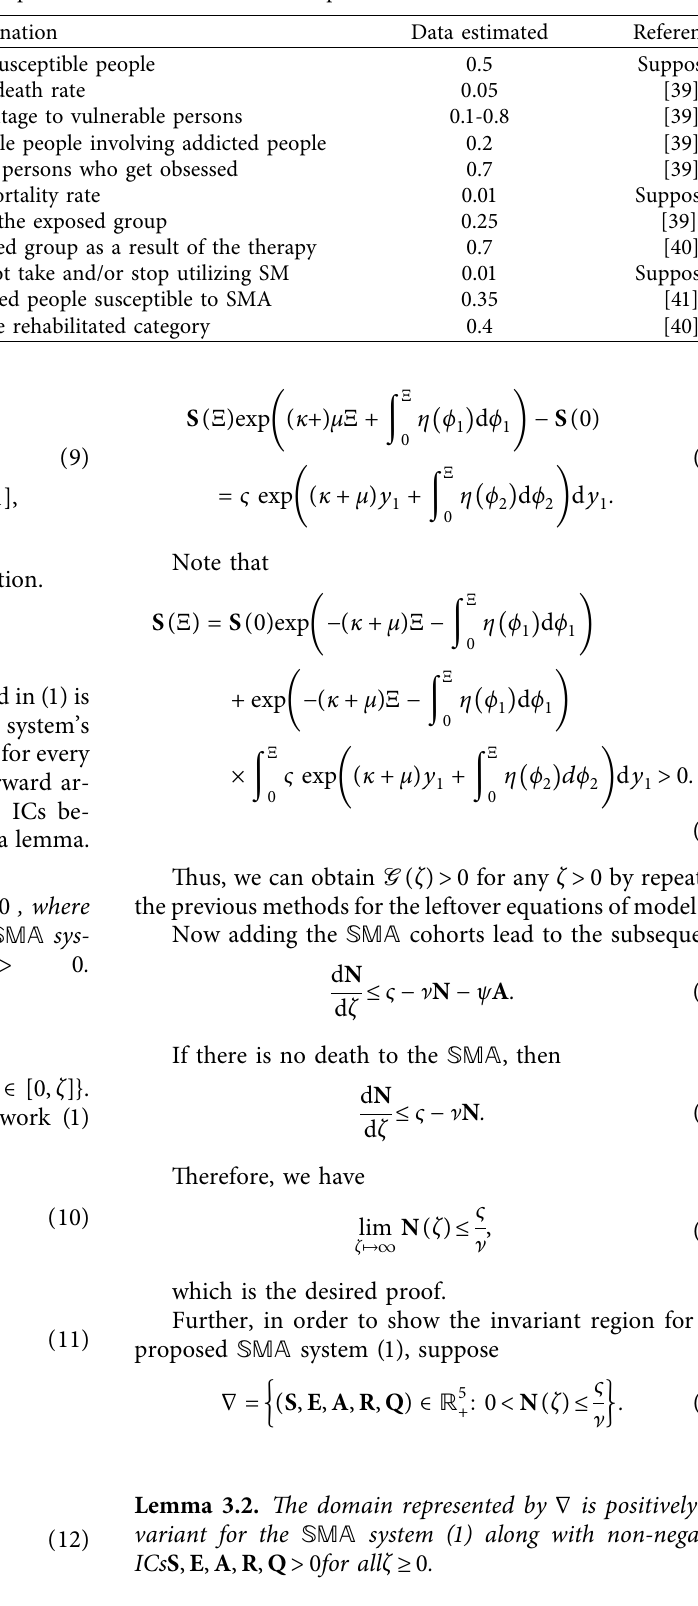
Table 1: Table of specified variables and their